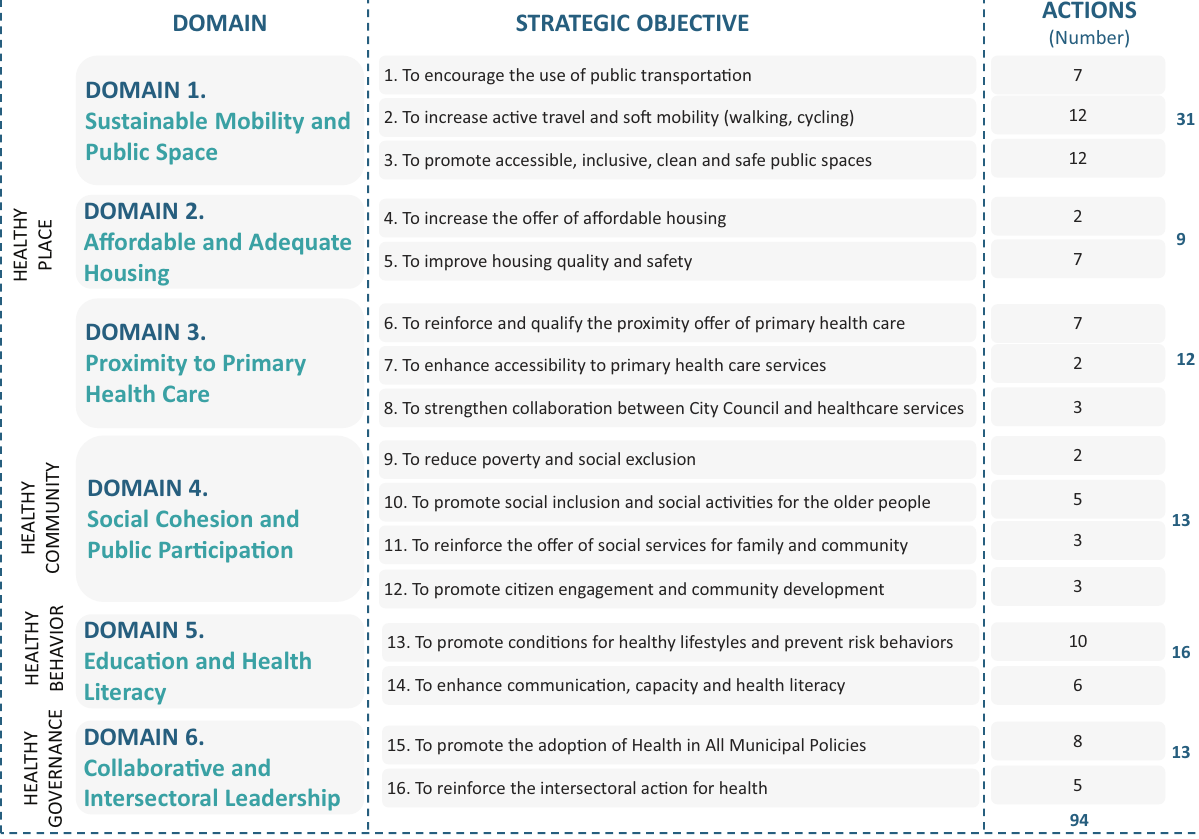
Figure 10. Strategic objectives and number of actions by policy domain. Source: Source: Câmara Municipal de Coimbra and University of Coimbra